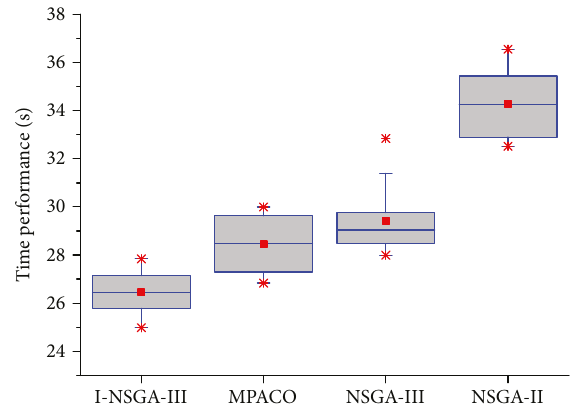
Figure 8: Time performance of four di ff erent algorithms. ∗ represent extreme outliers.